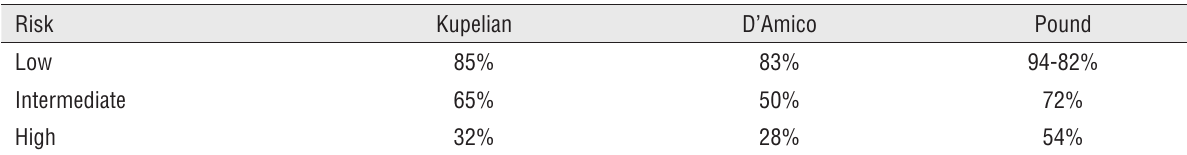
Table 4a - 5 year biochemical freedom from failure rate published by Kupelian, D’ Amico and Pound after radical prostatectomy in different risk groups.